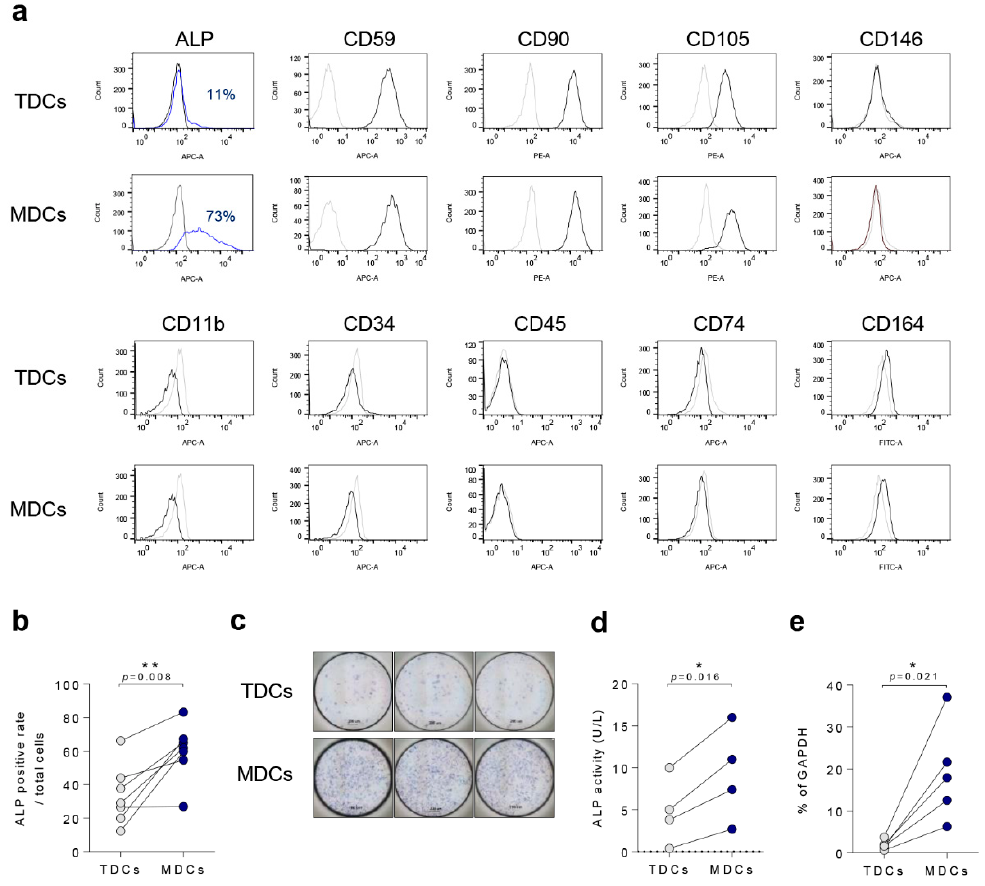
Figure 1. ALP was highly expressed in MDCs compared with TDCs. ( a ) Tendon and muscle surface markers such as ALP, CD59, CD90, CD105, CD146, CD11b, CD34, CD45, CD74, and CD164 were analyzed by FACS. ( b ) Quantification of surface ALP expression (n = 6). ( c ) All TDCs and MDCs were cultured in growth medium for a day and cells were assessed with ALP staining (scale bar = 200 µ m, ( d ) ALP activity (n = 4), or ( e ) qPCR for ALP mRNA expression (n = 5). *, p < 0.05; **, p < 0.01. Data are presented as the mean ± SEM.